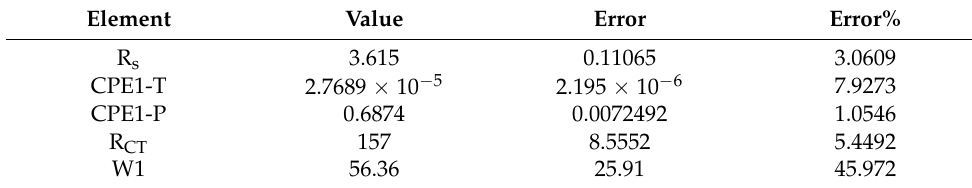
Figure 5. AC impedance spectroscopy of ZnO/Co 3 O 4 . Table 1. Circuit element fitting parameters.